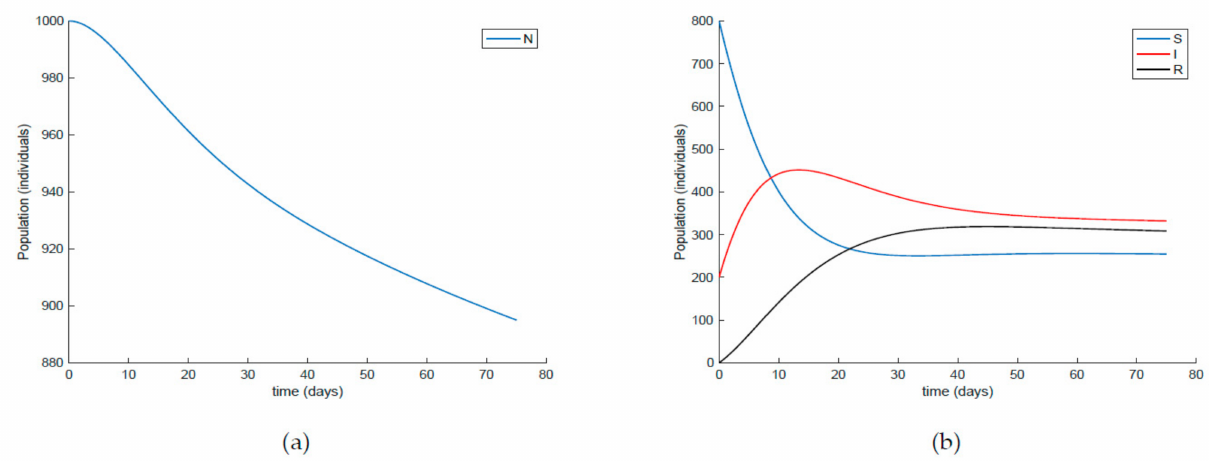
Figure 1. ( a ) Evolution of the total population, and ( b ) each subpopulation according to model (1)–(3) with parameter values given by Table 1 and in the absence of external